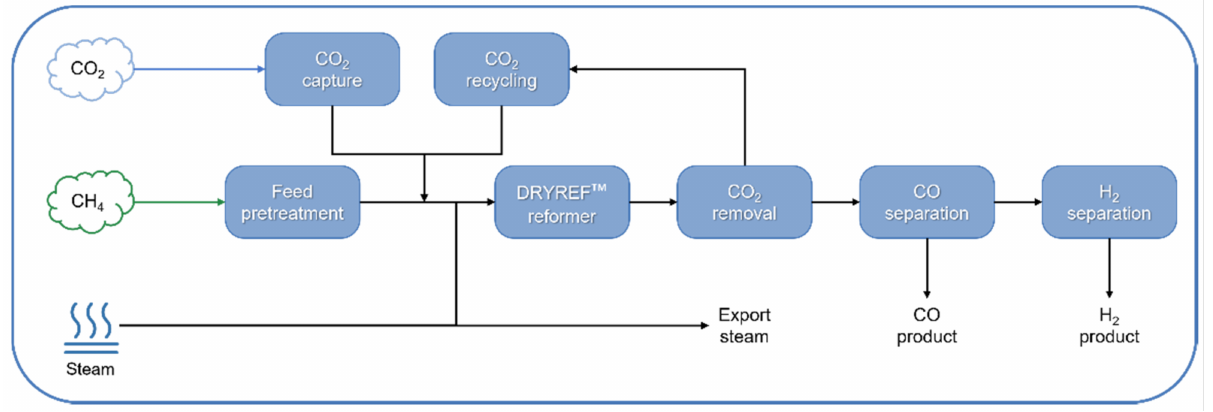
Figure 10. Simplified block diagram of the DRYREF™ process for CO and H 2 production